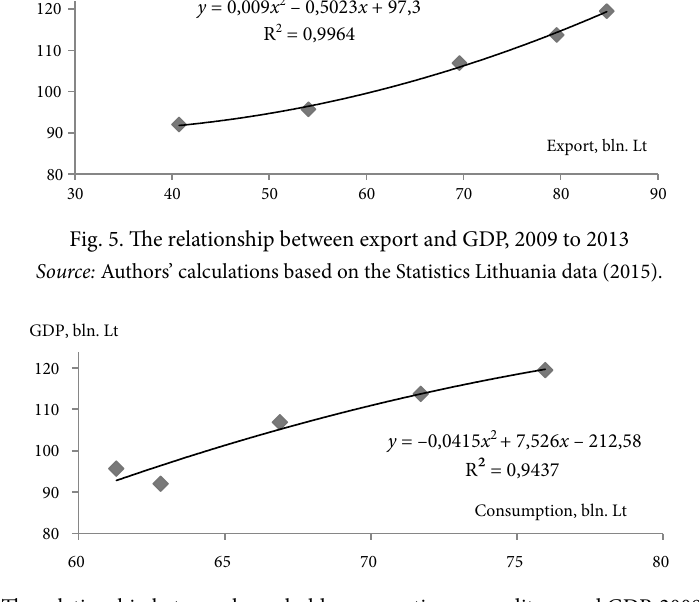
Fig. 6. The relationship between household consumption expenditure and GDP, 2009–2013 Source: authors’ calculations based on the Statistics Lithuania data